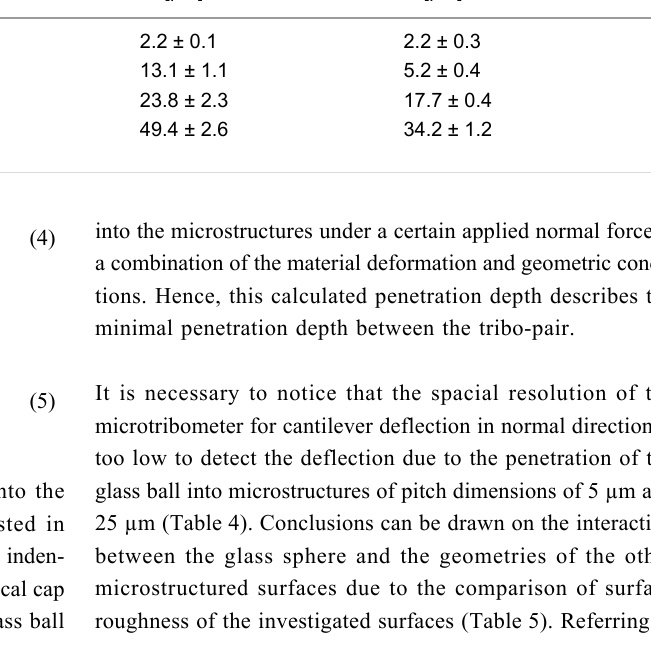
Table 3: Exact geometry of each PGMS pattern (mean values and standard deviations) measured by white-light interferometer. λ : pitch dimension, A : periodicity of the structure, W : width of the structure and D : depth of the grooves. sample